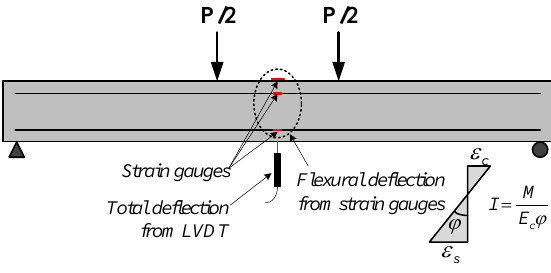
Figure 2. Flexural and total deflections of an RC beam.